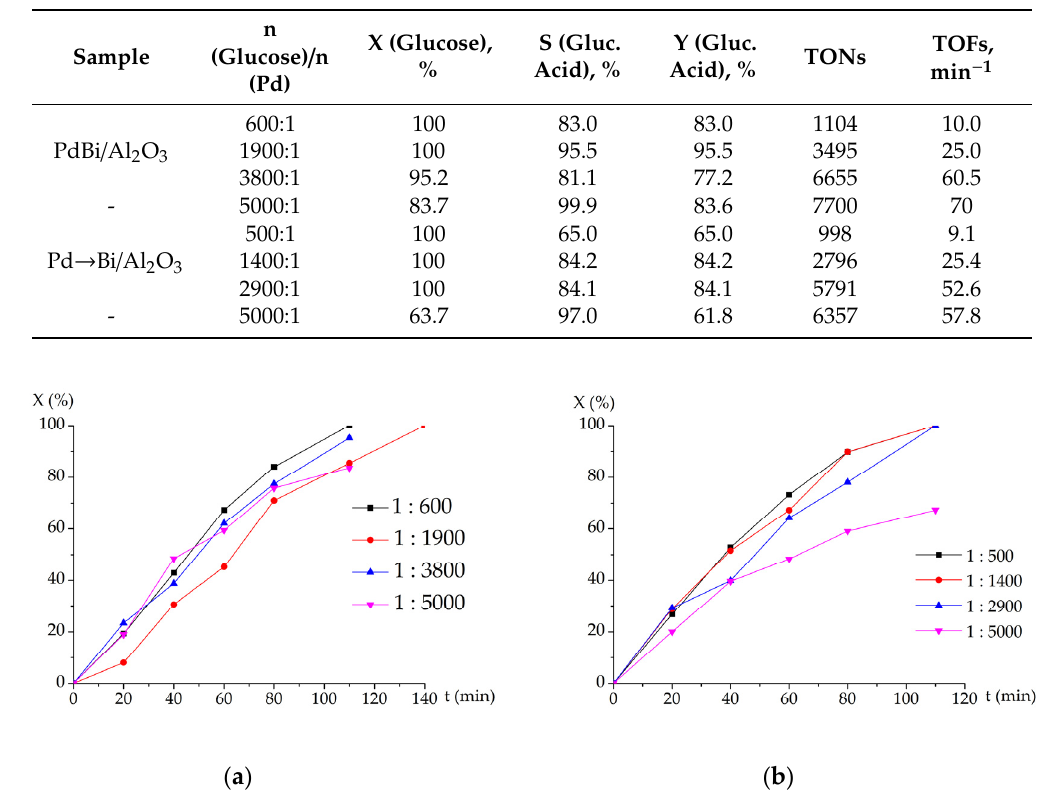
Figure 12. Dependence of glucose conversion (X) on time (t) in the presence of the catalyst ( a ) PdBi/Al 2 O 3 ( b ) Pd → Bi/Al 2 O 3 .